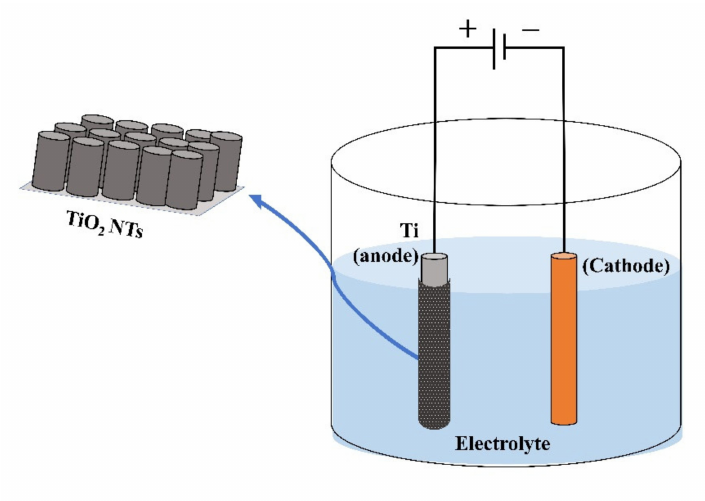
Figure 1. The electrochemical anodization process for obtaining TiO 2